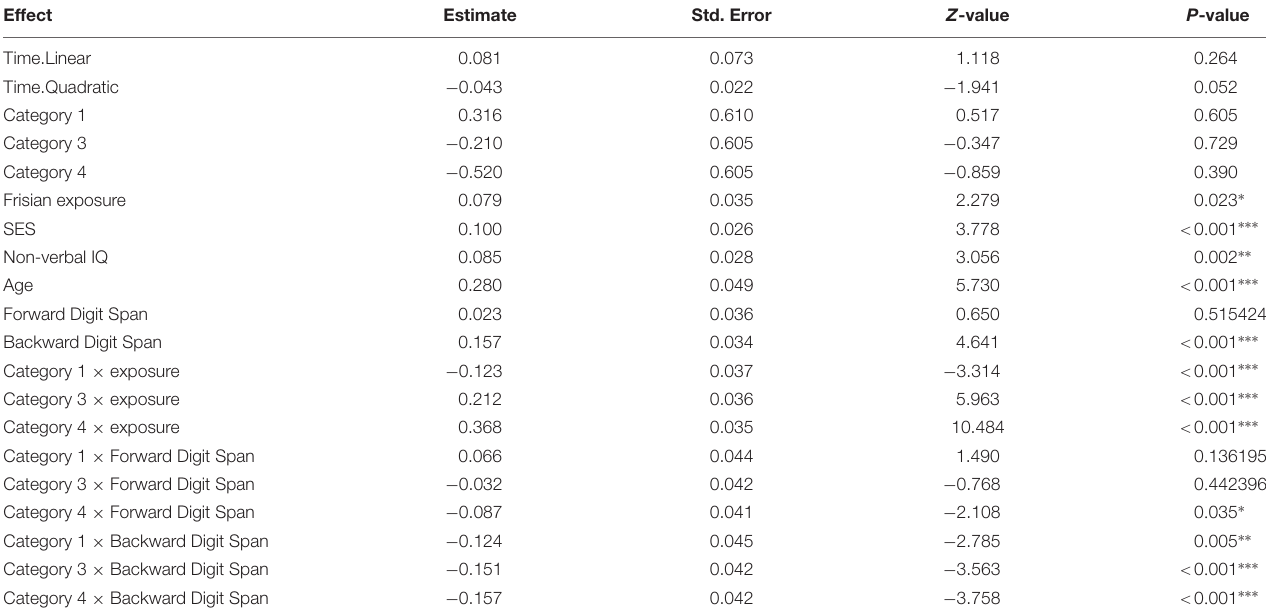
TABLE 4 | Fixed effects from the final model with Frisian receptive vocabulary accuracy as dependent variable and category 2 as reference level.